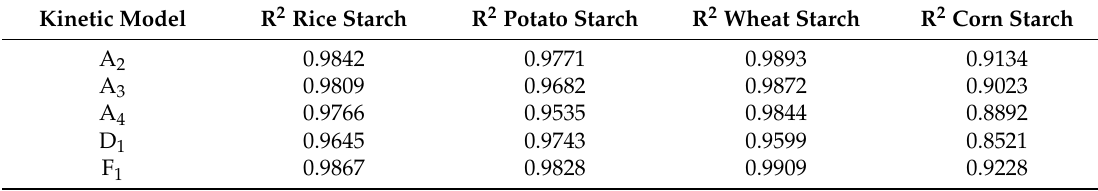
Table 2. Linear fit of plots for recommended adopted kinetic mechanism for the CR